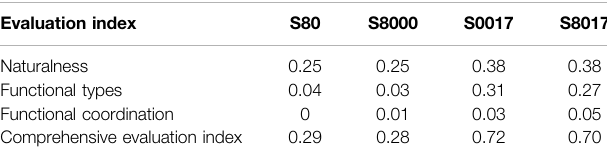
TABLE 6 | Comprehensive evaluation index results of slope ecological restoration at different construction